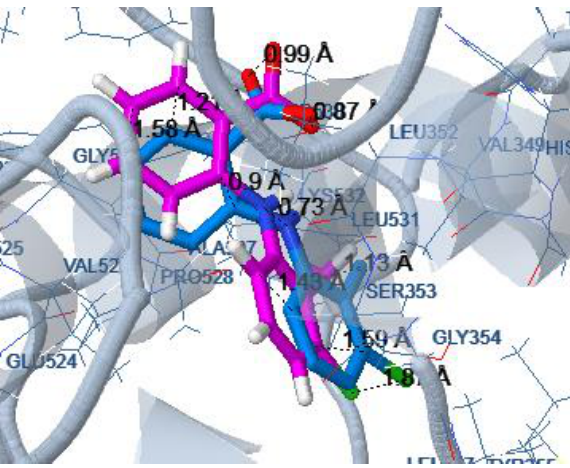
Figure 10. Docking of tolfenamic acid to the structure 5IKT of human COX-2 (docked molecule in blue, initial molecule in magenta), the distances between the same atoms of the two structures do not exceed 1.6 Å .